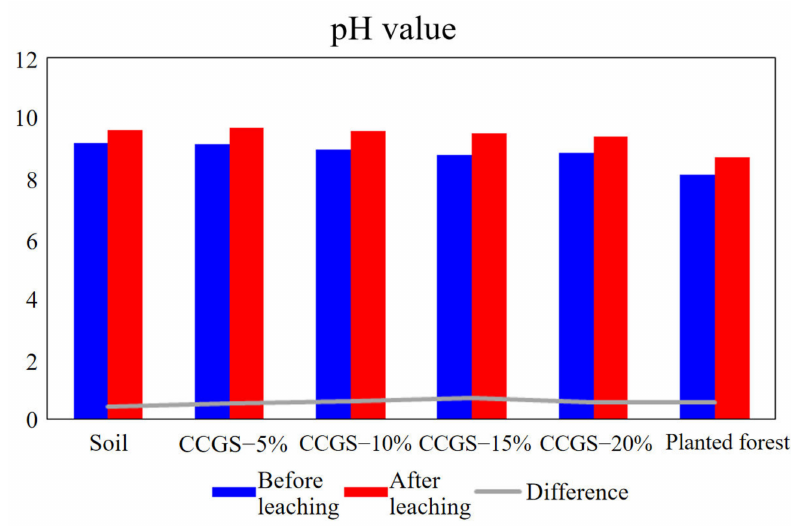
Figure 12. Effects of CCGS on soil pH.